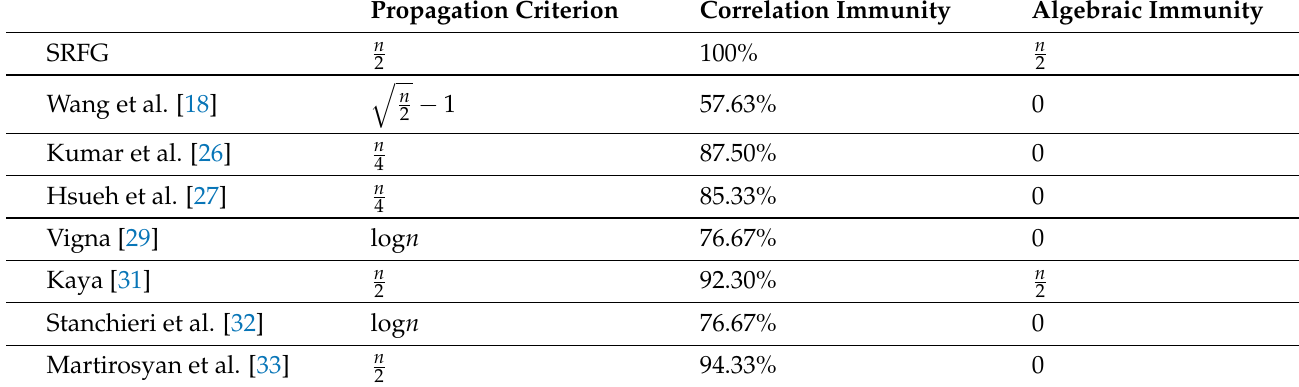
Table 2. Comparative feature